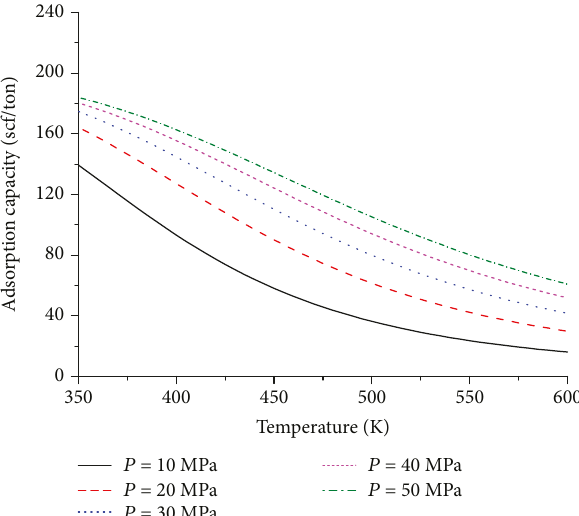
Figure 2: Adsorption capacity change of shale gas with temperature under di ff erent